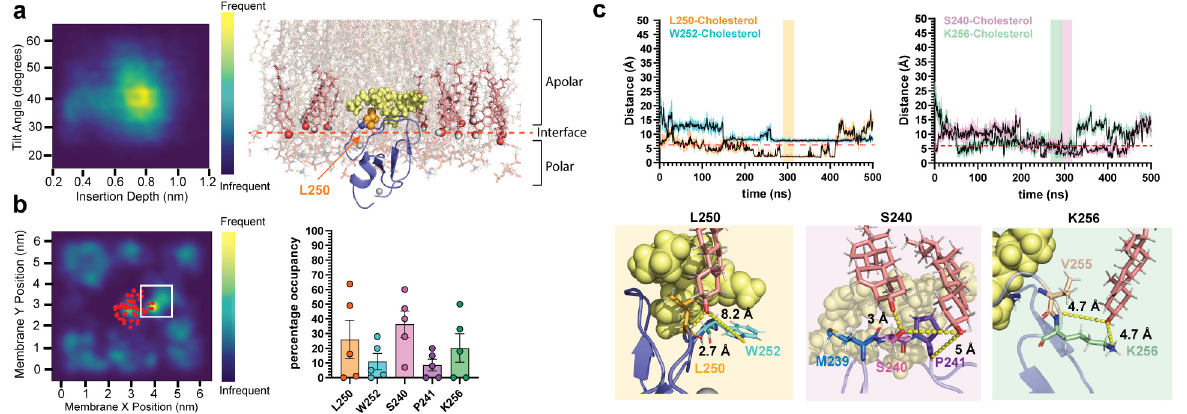
Figure 6. Topology of δ C1b-Merle27 and its interaction with cholesterol. ( a ) Topology heatmap of δ C1b-Merle27 showing the average insertion depth and tilt angle (averaged from five independent 500 ns simulations over a total of 2.5 μ s). Representative snapshot showing the relative position of δ C1b-Merle27 to cholesterol hydroxyl groups (red spheres) and the membrane interface. L250 is shown as orange spheres. The polar:apolar interface is indicated by the dashed red line. ( b ) Heatmap showing the localization of cholesterol in the inner leaflet across the 500 ns simulation time. Data shown are representative of five simulations (full dataset is shown in Figure S4). Residue occupancy with cholesterol is quantified in the bar graph across all five simulations. Bars indicate the mean with the standard error of the mean shown as the error bar and each point represents a single independent simulation. ( c ) The interaction lifetime between W252 (cyan), L250 (orange), S240 (pink) and K256 (green) with cholesterol-hydroxyls is plotted. Representative structures from the region indicated by the shaded area in the interaction lifetime plot are shown with the key residues indicated. Cholesterol molecules are shown as pale red